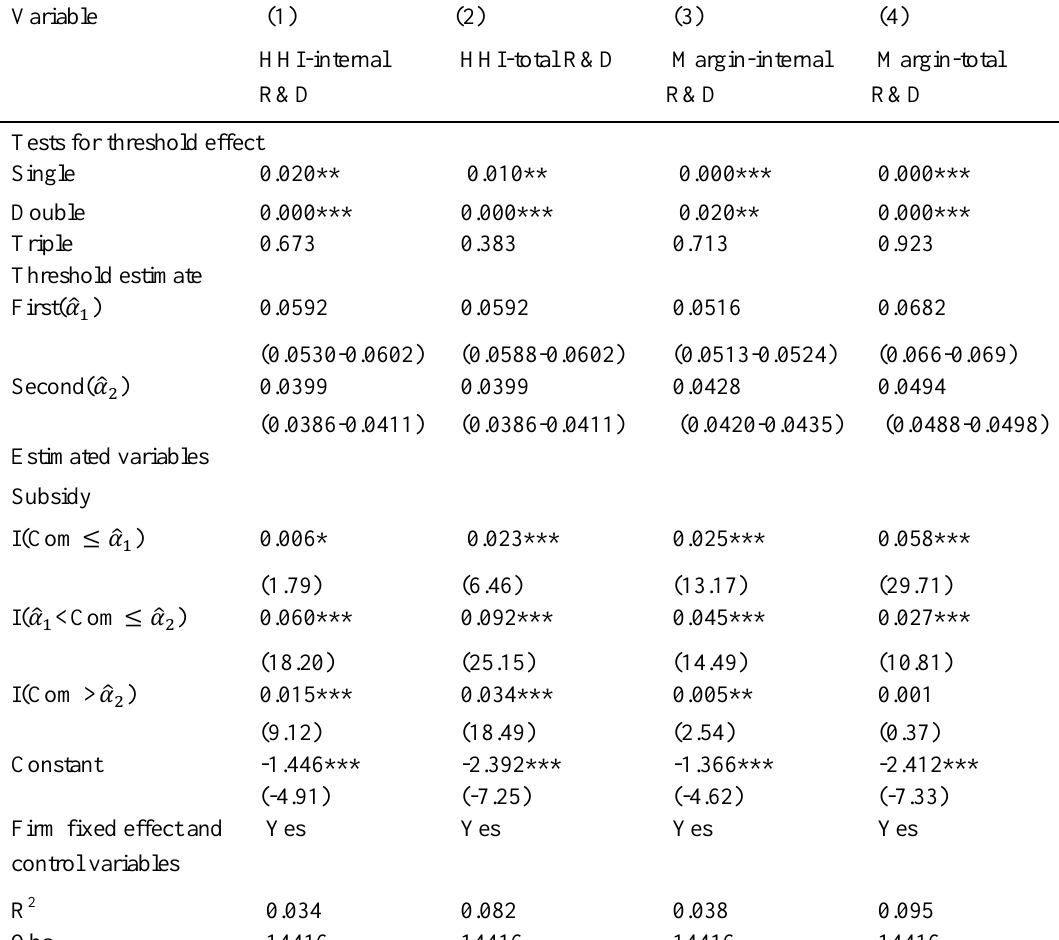
Table 6 : Other R&D subsidy proxies: one year lag of the R&D subsidy